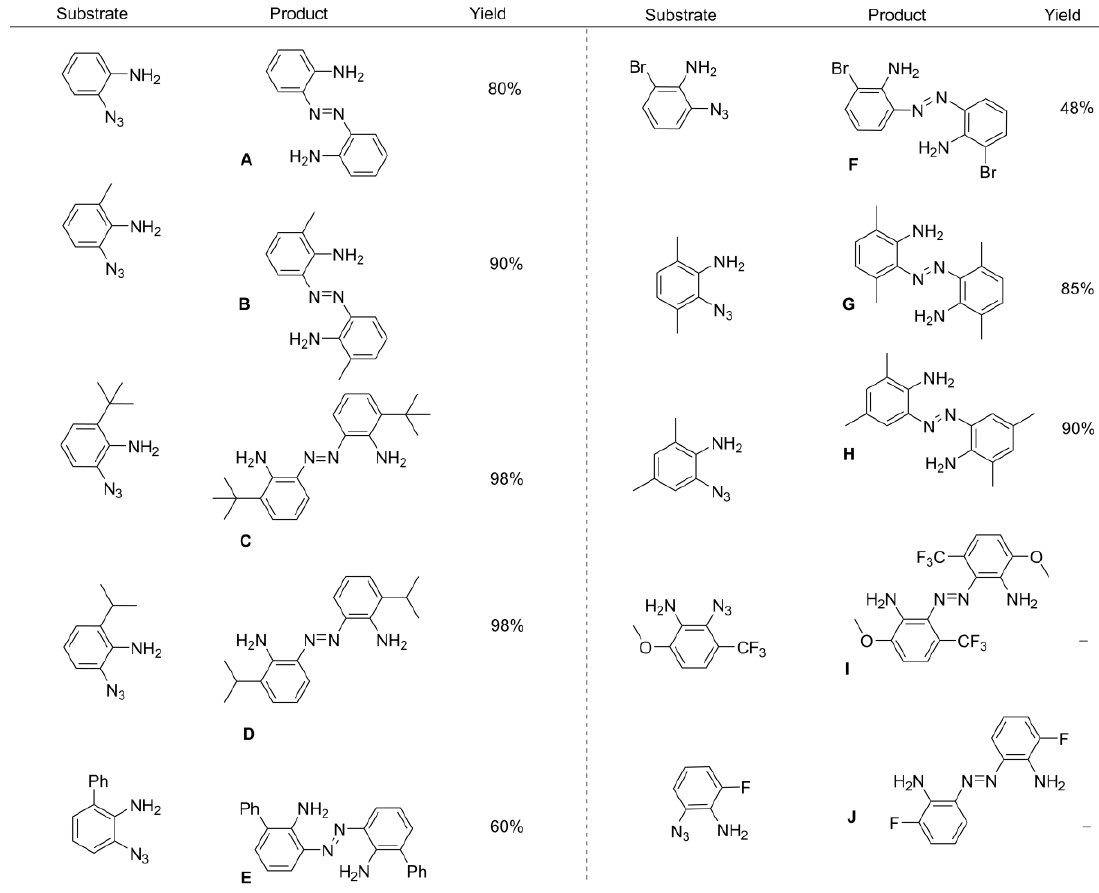
Figure 1. Substrate screening for [Co II (TPP)] catalyzed synthesis of azobenzenes from o -amine substituted azides *. * All reactions were carried out with 0.3 mmol of azide, [Co II (TPP)] (5 mol%) in 4 mL of toluene. The reaction mixtures were bubbled with dinitrogen for 15 min prior to thermostatting at the stated temperature for 18 h. Isolated yields are